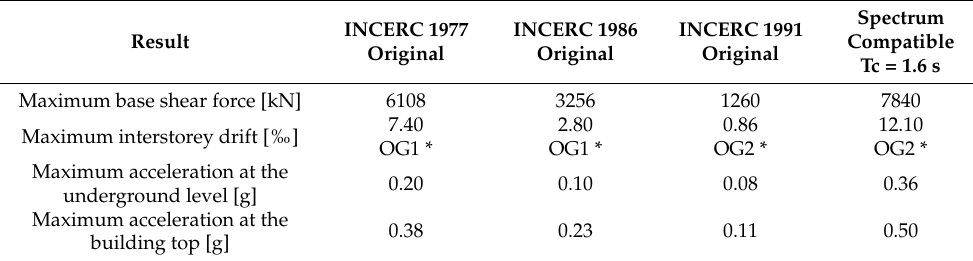
Table 4. Results from non-linear time-history analysis for the building designed according to the capacity